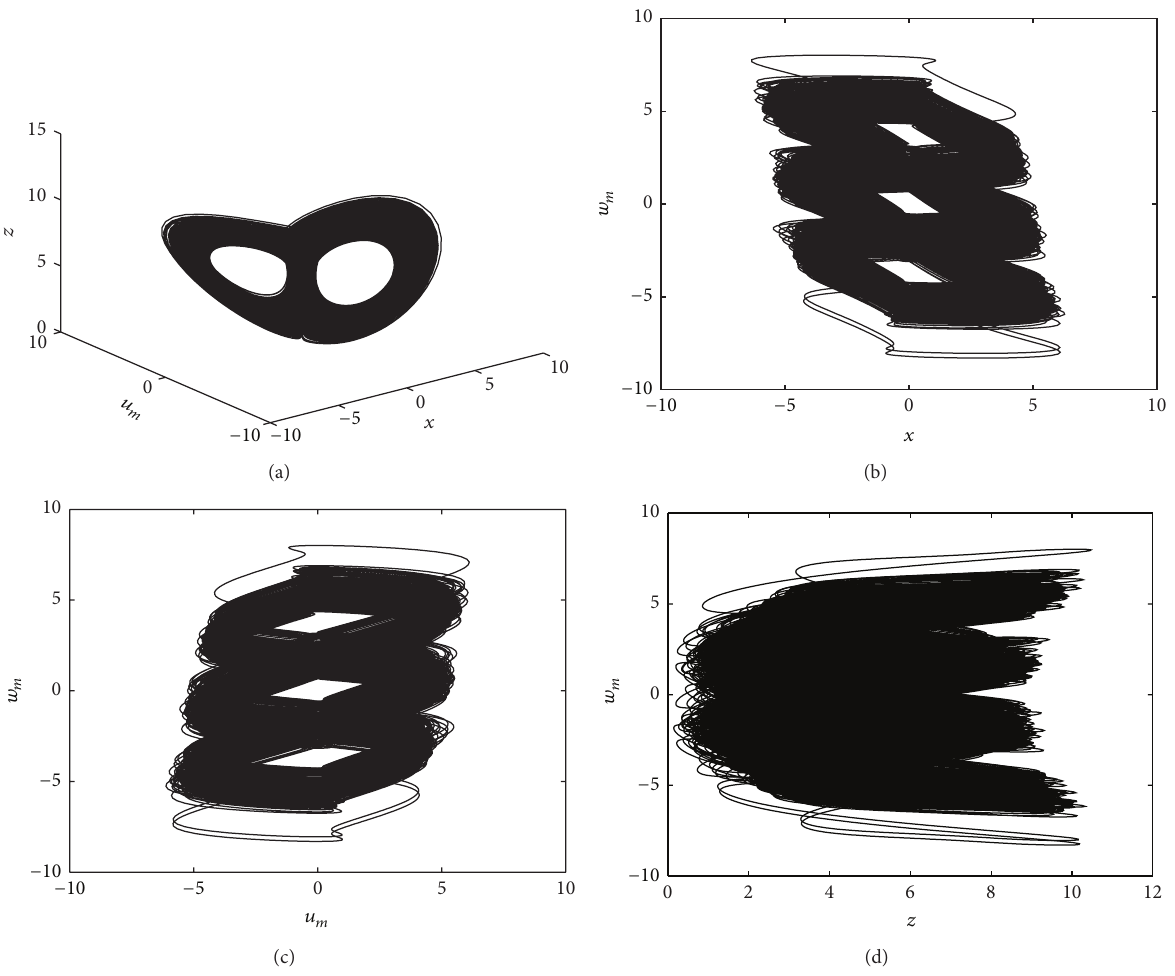
Figure 2: Hyperchaotic attractor without equilibrium obtained from system (5) for 𝑎 = 5 , and 𝑏 = 0.001 (a) in the 𝑥 − 𝑢 𝑚 − 𝑧 space, (b) in the 𝑥 − 𝑤 𝑚 plane, (c) in the 𝑢 𝑚 − 𝑤 𝑚 plane, and (d) in the 𝑧 − 𝑤 𝑚 plane.